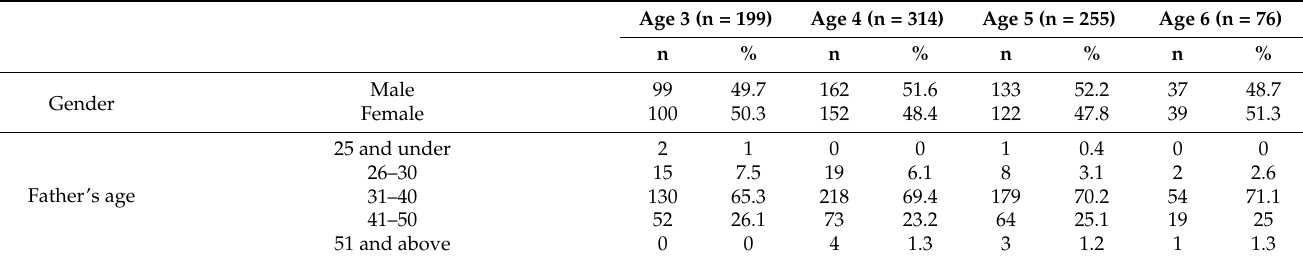
Table 1. Demographic Characteristics of the